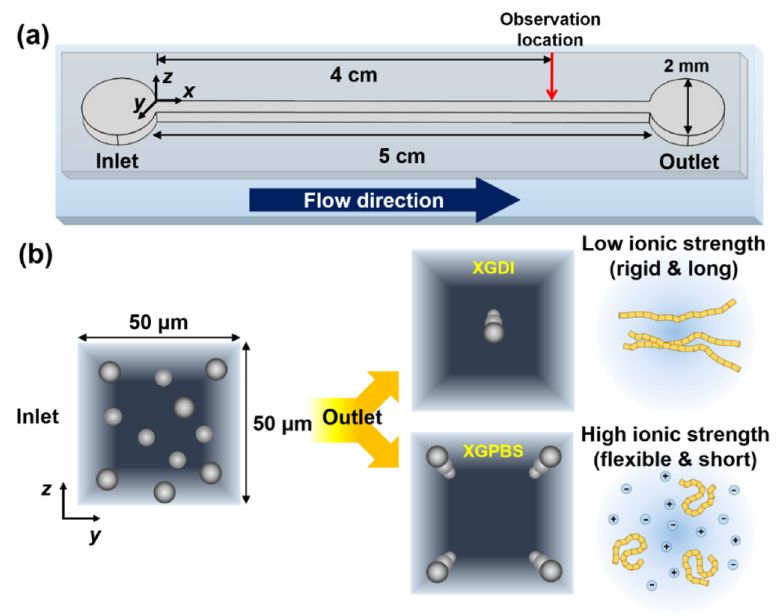
Figure 1. ( a ) Schematic of 5 cm long straight, square microchannel (width × height = 50 µ m × 50 µ m). The viscoelastic fluid including the polystyrene (PS) beads was injected through the inlet and the distribution of the PS beads (diameter = 10 µ m) was observed 4 cm downstream from the inlet. ( b ) Schematic diagrams of random particle distributions at the inlet, and the equilibrium particle positions 4 cm downstream from the inlet in the xanthan gum (XG) solutions in deionized (DI) water (XGDI) or phosphate bu ff ered saline (PBS) solution (XGPBS). The XG molecules adopt di ff erent molecular structures according to the solvent ionic strength: rigid and long in DI water; flexible and short in PBS solution [26].